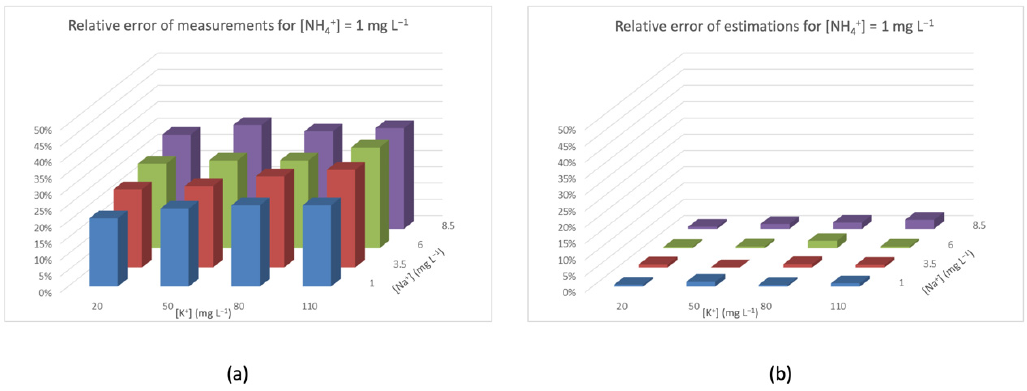
Figure 6. Relative error for [NH 4+ ] = 1 mg L − 1 ( a ) measured by the ISE and ( b ) after TMR and interference rejection.